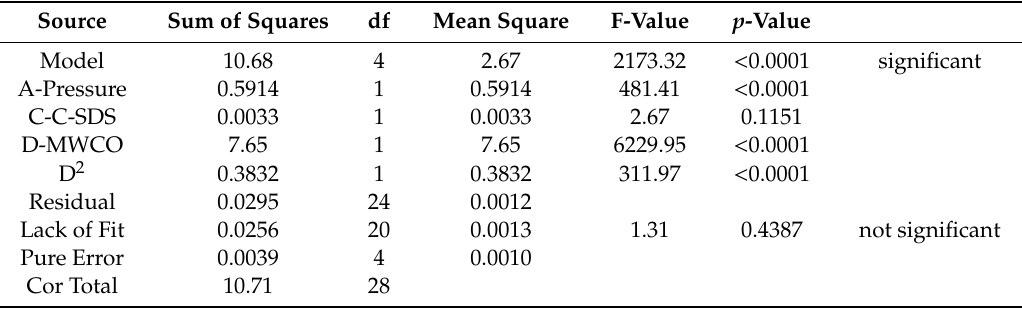
Table 6. ANOVA for reduced quadratic model (response: